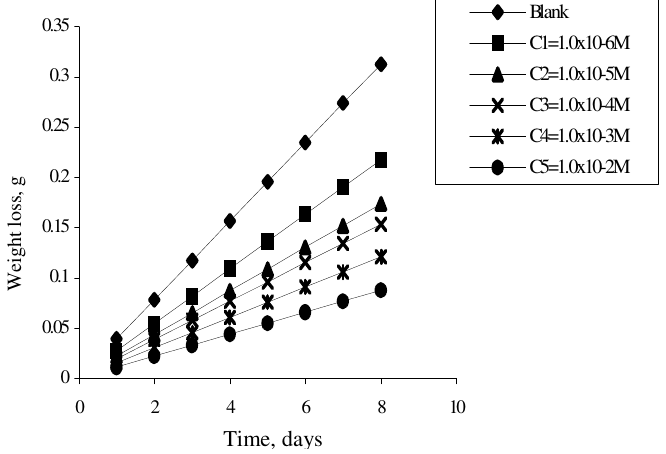
Figure 7. Variation of weight loss (g) with time (days) for mild steel coupons in 2 M HCl solution containing different concentrations of pyridoxolhydrochloride at 303K. The corrosion rate of the metal decreases with increase in the concentration of the